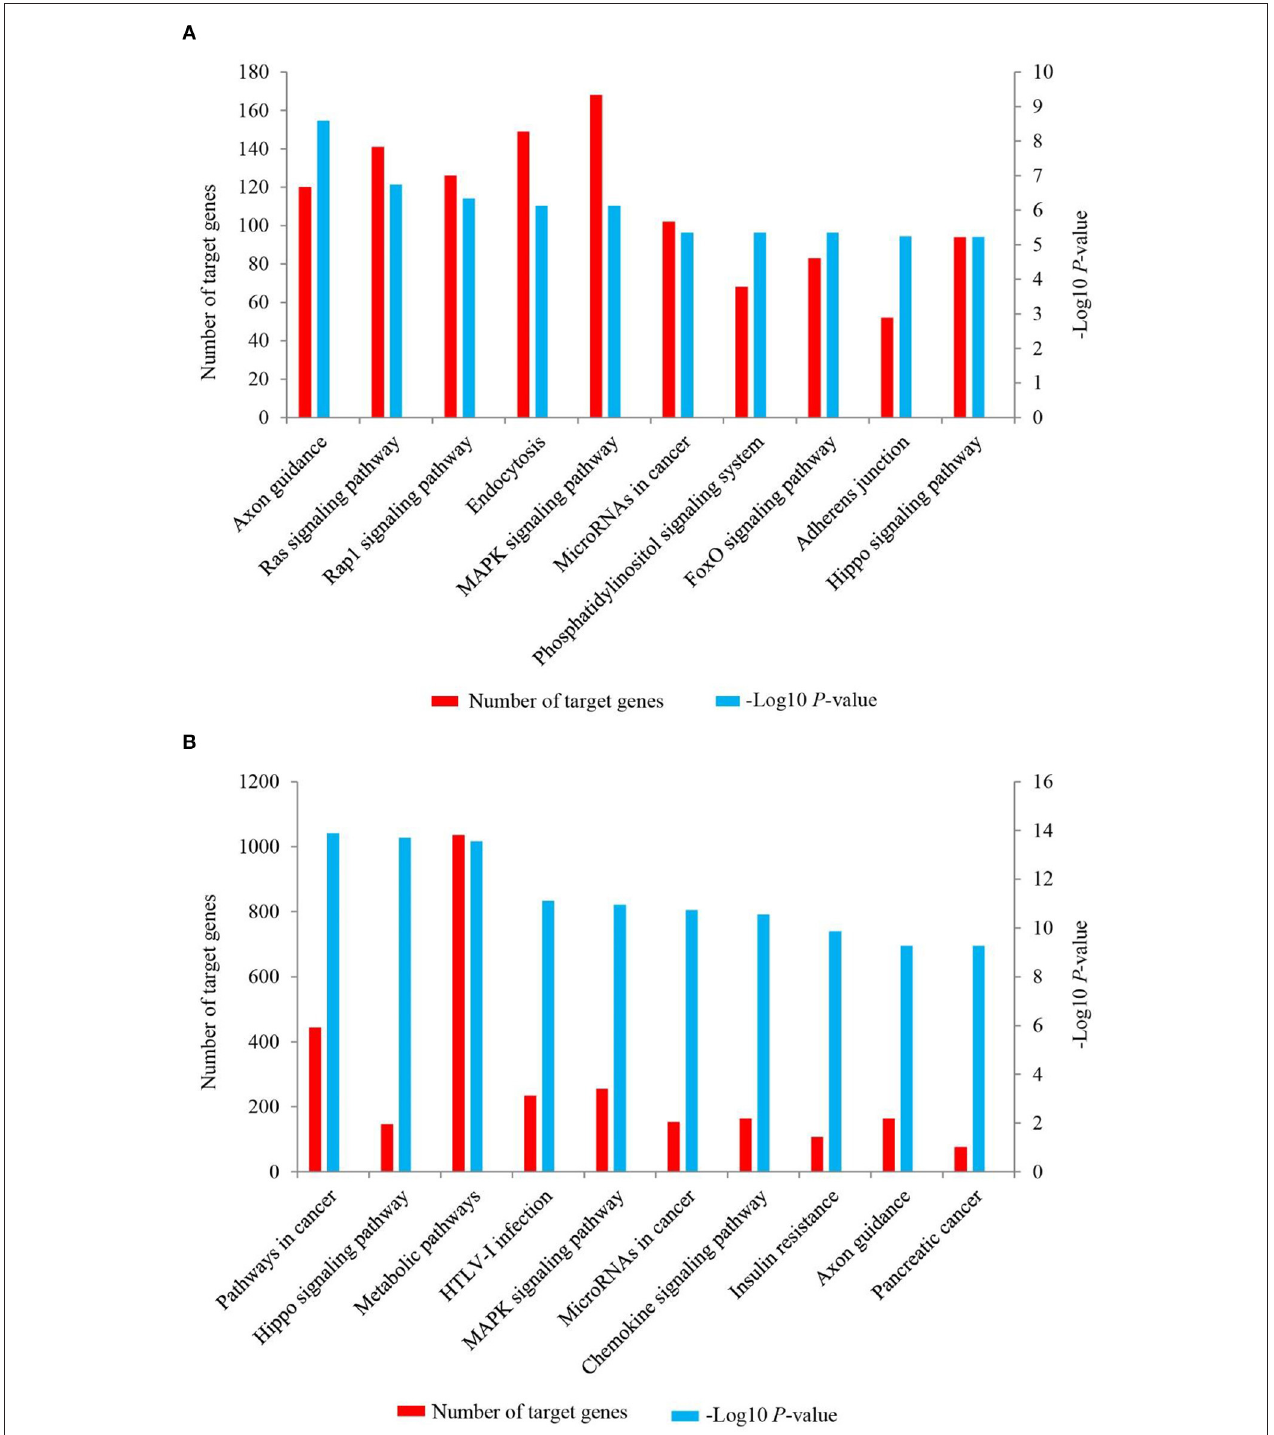
FIGURE 6 | The top 10 KEGG signaling pathways for the target genes of up-regulated (A) and down-regulated (B) miRNAs in the Longissimus dorsi muscle of Liaoning cashmere (LC) goats compared to Ziwuling black (ZB) goats. The left side Y-axis represents the number of the target genes of differentially expressed miRNAs involved in the pathway, while the Y axis on the right side shows the value of -Log10 ( P -value).